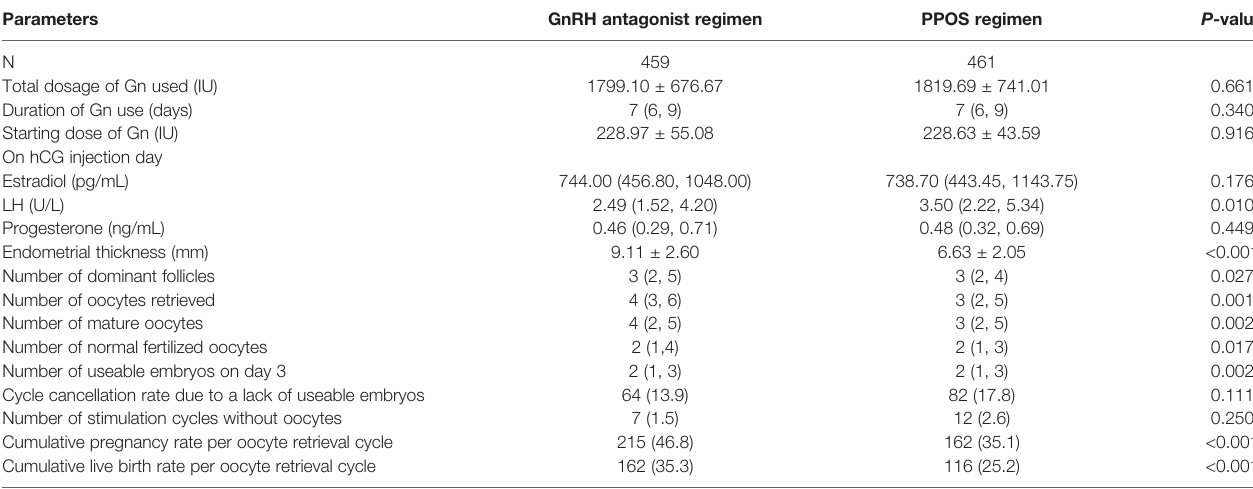
TABLE 2 | Comparison of clinical and laboratory indicators between two COS regimens.